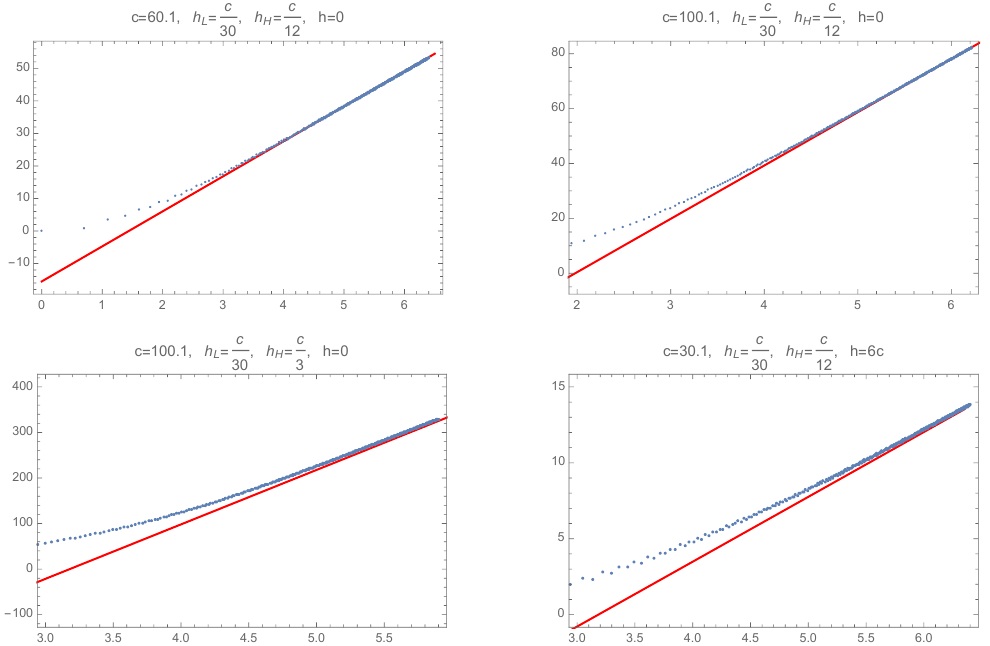
Figure 14 . The behavior of the coe(cid:14)cients of the q 2 n term in the polynomial H in (2.4) compared to the prediction (3.8). The horizontal axis is log n and the vertical axis is log c n , where c n is the coe(cid:14)cient of q 2 n in H . The red lines are power-laws an s with the constant a determined by the